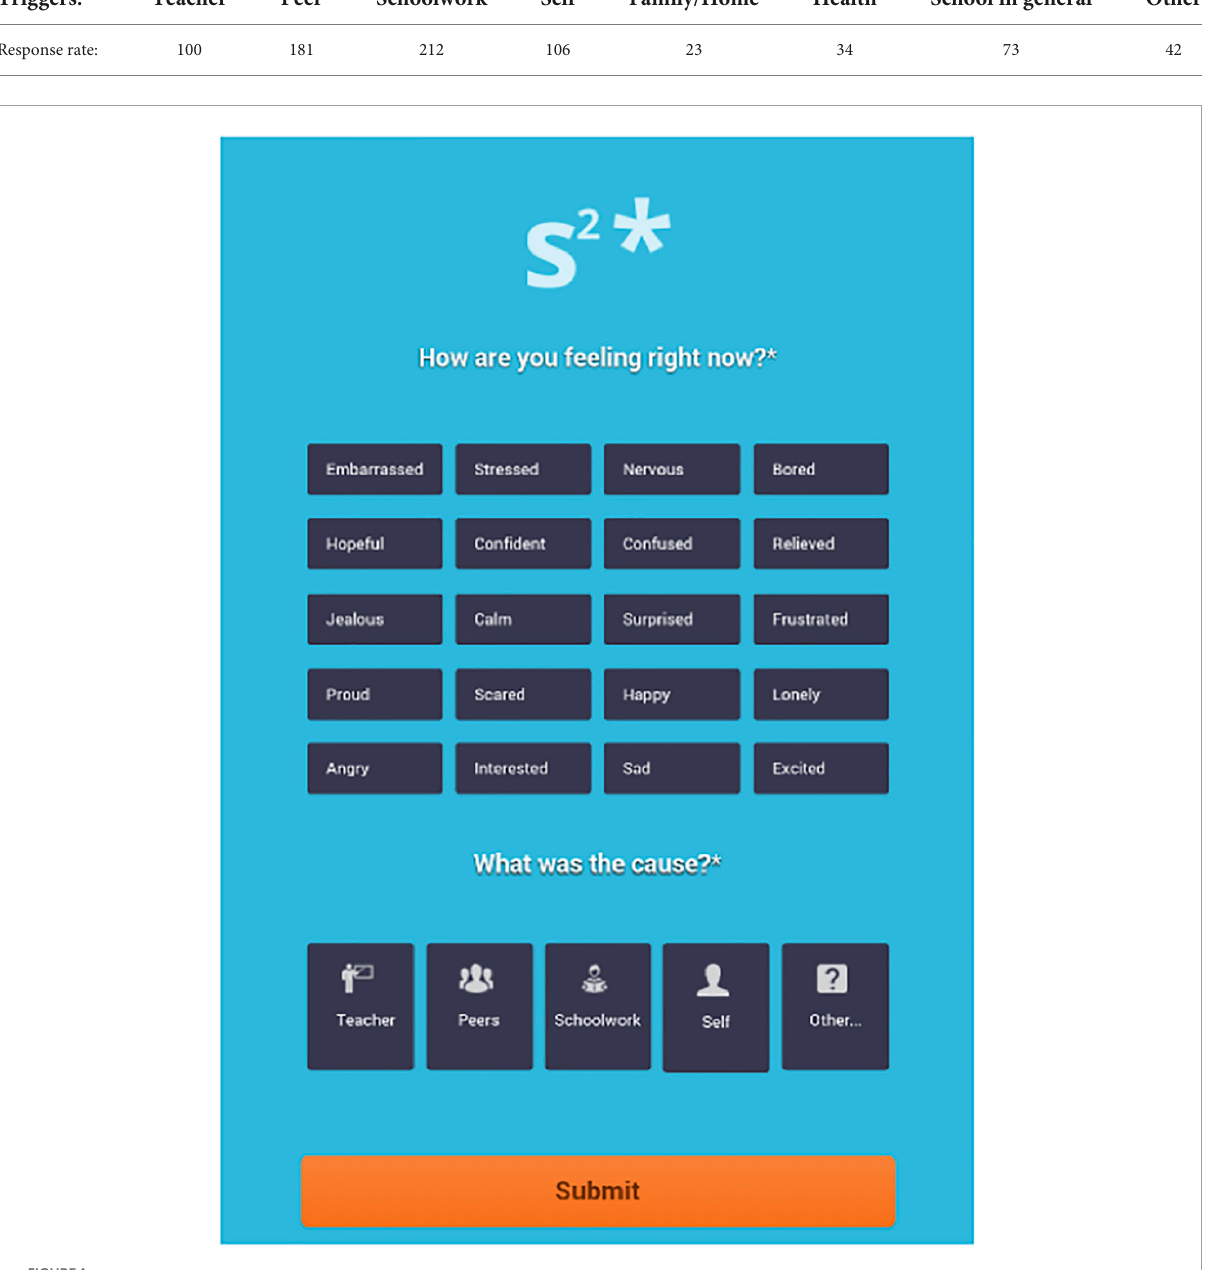
FIGURE1 Interface of the S 2 * emotion application.